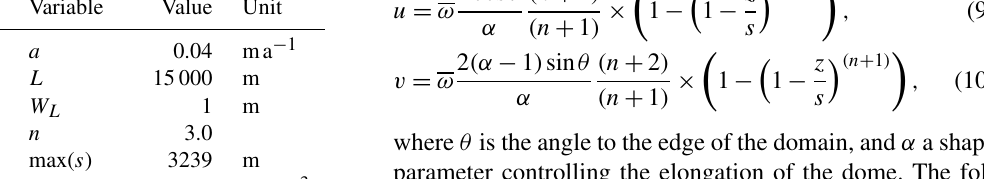
Table 1. Description and values of the model parameters. Parameter